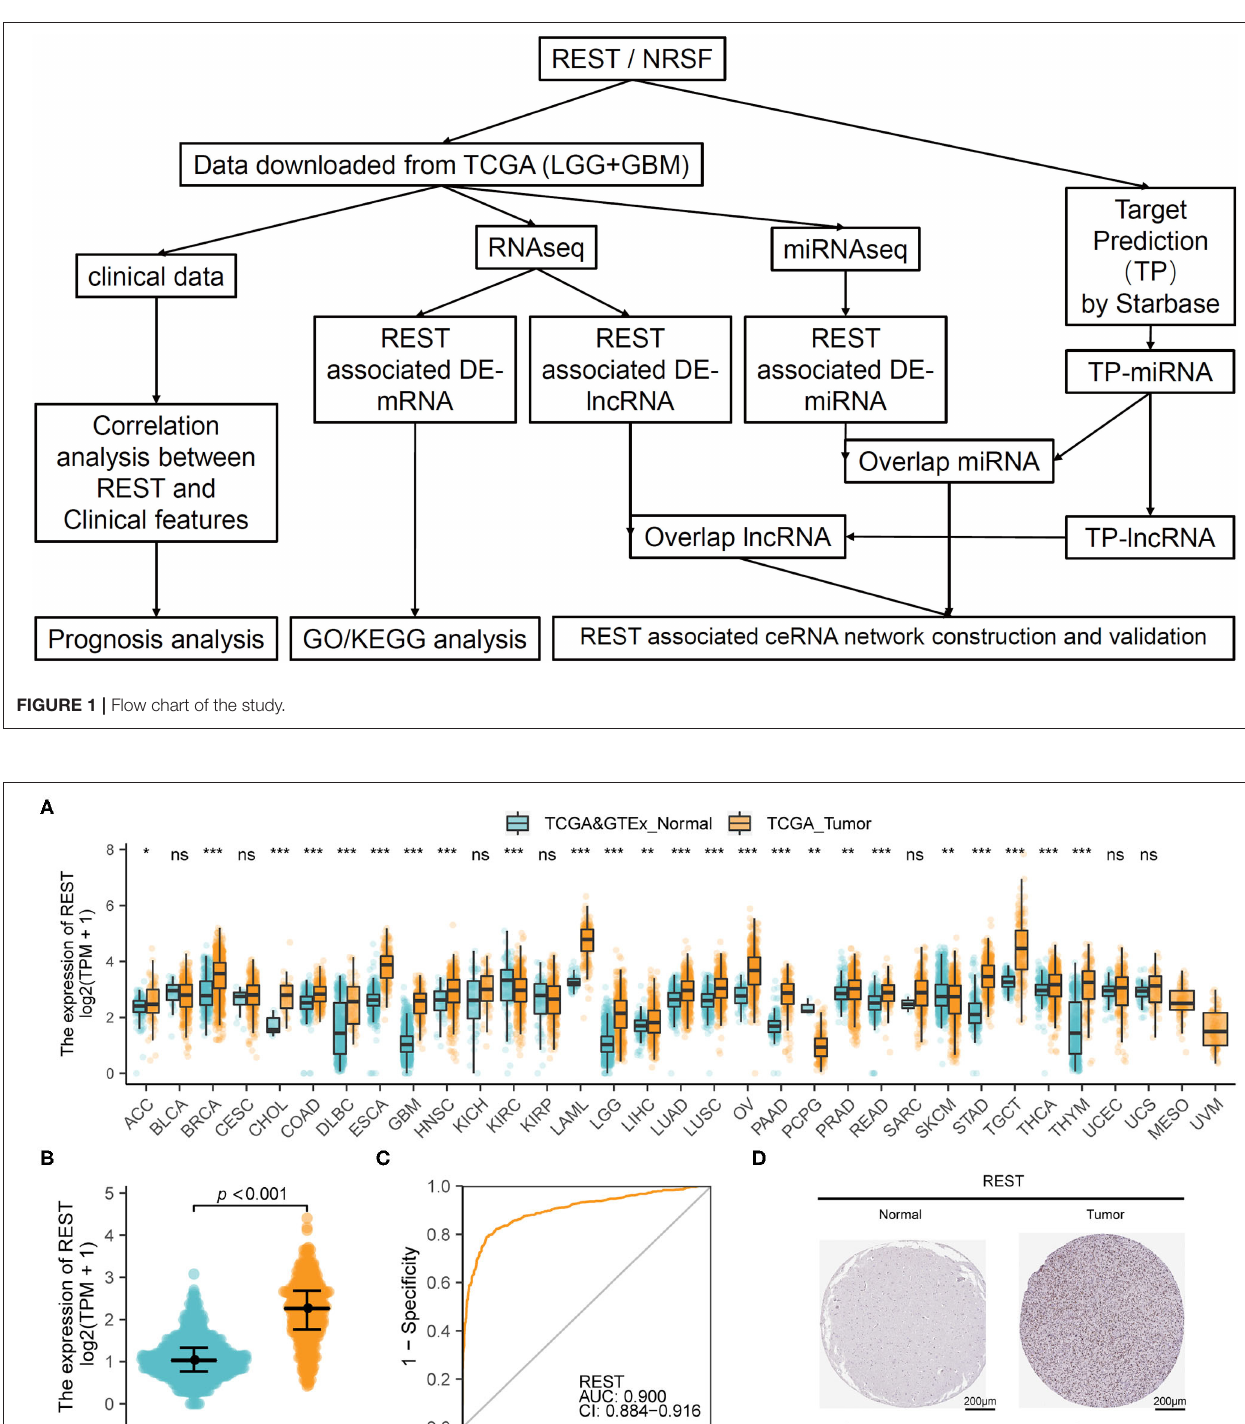
Frontiers in Medicine |